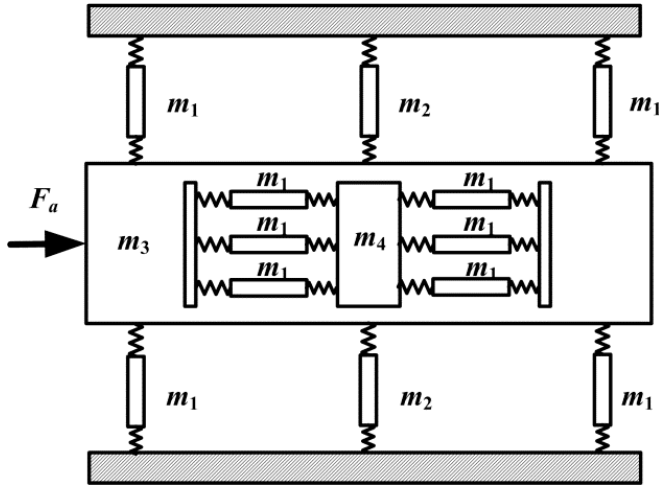
Figure 6. Dynamic model of the proposed 2-DOF piezoelectric-driven platform.